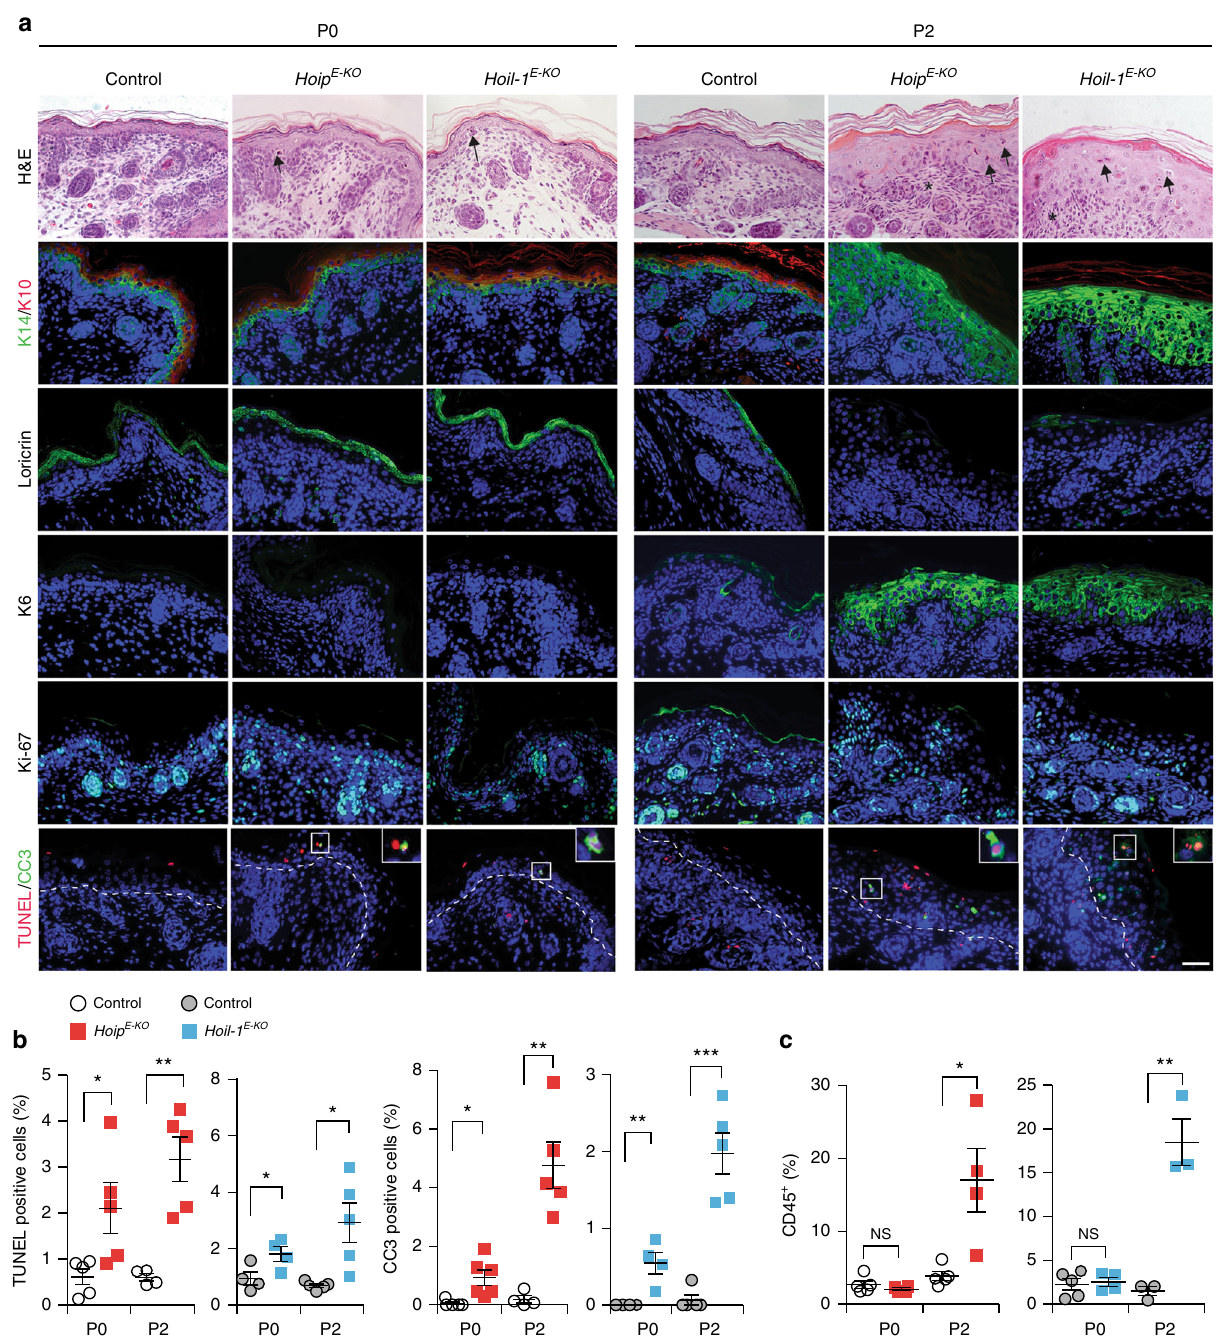
Fig. 3 Cell death precedes the onset of in fl ammation in Hoip E-KO and Hoil-1 E-KO mice. a Representative images of skin sections stained with H&E, the indicated antibodies or TUNEL from mice of the indicated genotypes ( n = 3 mice per genotype). Arrows: pyknotic nuclei, stars: immune cell in fi ltrates. Nuclei were stained with DAPI (blue). White dashed lines indicate boundary of epidermis (above) and dermis (below). Scale bar, 50 µ m. b Quanti fi cation of TUNEL- and cleaved caspase-3 (CC3)-positive cells in skin sections from mice of the indicated genotypes. Data are presented as mean values ± s.e.m. ( n < 4 mice per genotype). * P ≤ 0.05, ** P ≤ 0.01, *** P ≤ 0.001. c Percentages of CD45 + cells in the skin of the indicated genotypes at the indicated stages. Data are presented as mean values ± s.e.m. ( n o 3 per genotype). ** P ≤ 0.01, *** P ≤ 0.001, NS: not signi fi cant. Control mice represent a pool of Hoip fl / fl ; K14-Cre − and Hoip fl /wt ;K14-Cre + (white circles) or Hoil-1 fl / fl ;K14-Cre − and Hoil-1 fl /wt ;K14-Cre + (grey circles). P: postnatal